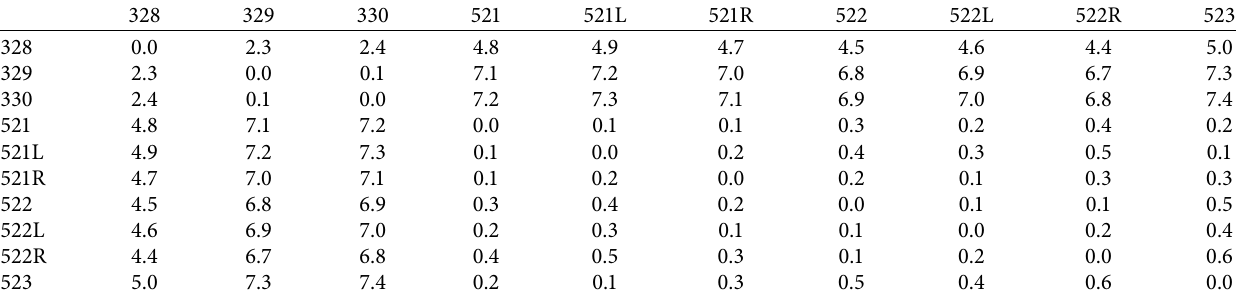
Table 6: OD distances calculated by the Floyd algorithm (partial).